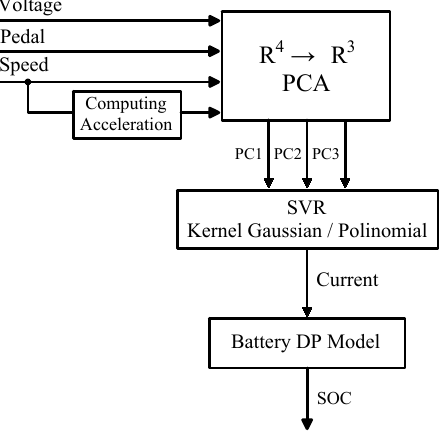
Figure 1. General description of the architecture used for state of charge estimation (SOC) estimation.